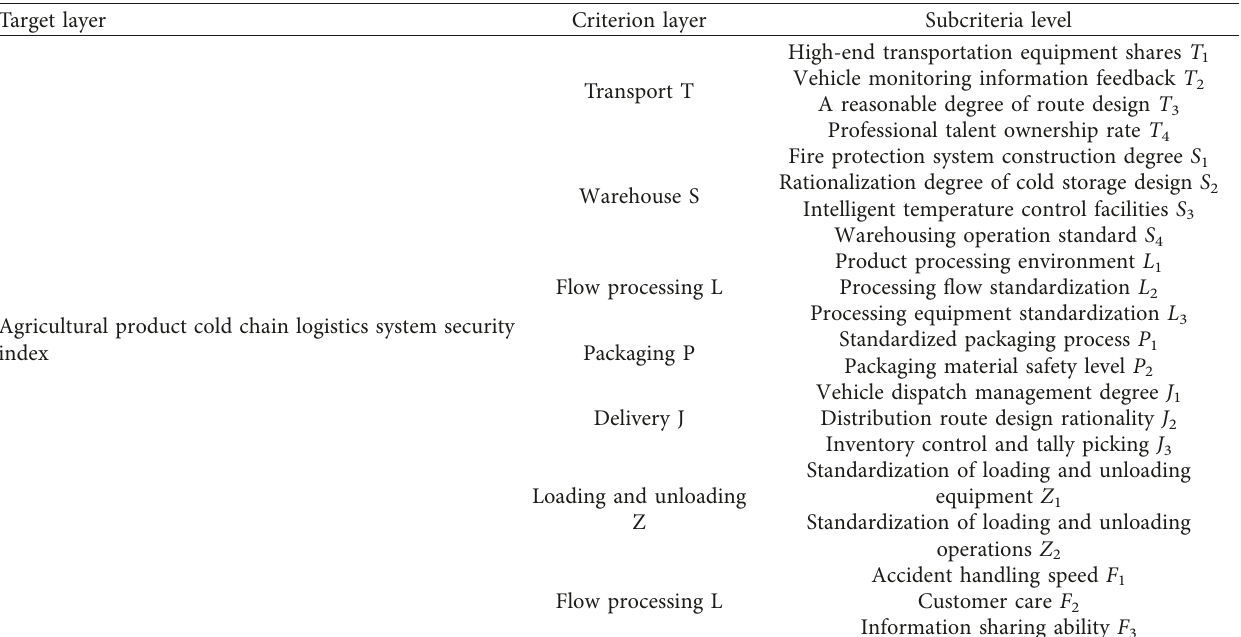
Table 4: Risk assessment indicators affecting the safety of fresh cold chain